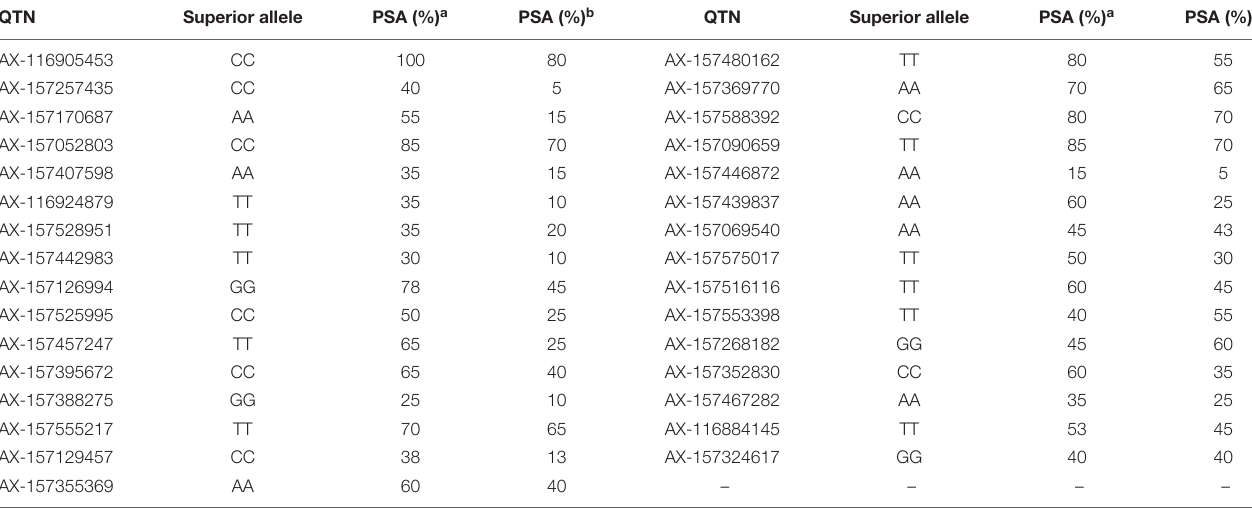
TABLE 5 | Superior alleles and their proportions of 31 common QTNs in 20 larger seed lines and 20 smaller seed lines.